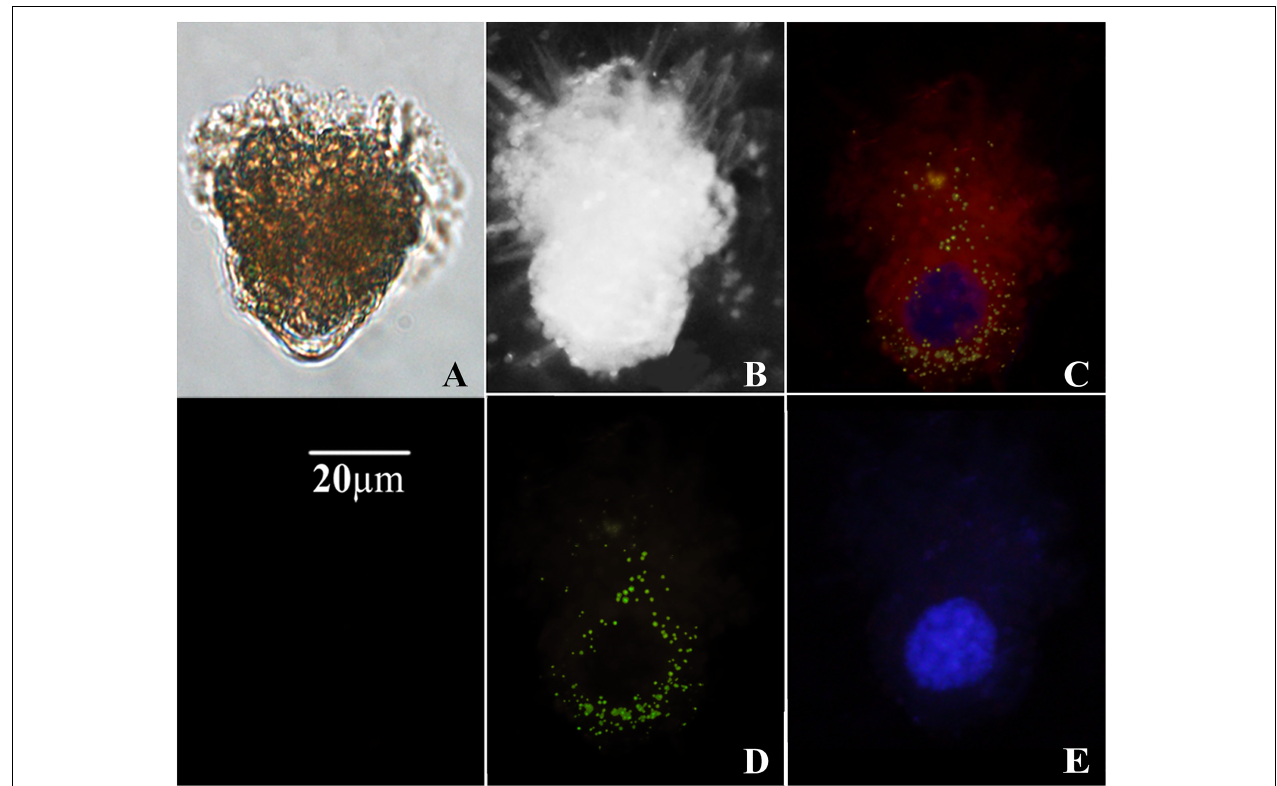
FIGURE 1 | Micrographs of Strombidium cf. basimorphum. (A) Light microscopy of a S. cf. basimorphum cell in liquid suspension (prior the collection on filter). (B) Bright field micrograph of a S. cf. basimorphum cell on filter. (C) Micrograph of the same cell on filter, acquired with combined light channels: the cell is hybridized with the probe for the prey rRNA (green) and counterstained with DAPI (blue). Sequestered chloroplasts are visible in red. (D) Micrograph of the same cell acquired with a single light channel for the FISH probe, showing prey rRNA. (E) Micrograph of the same cell acquired with a single light channel for DAPI, showing S. cf. basimorphum